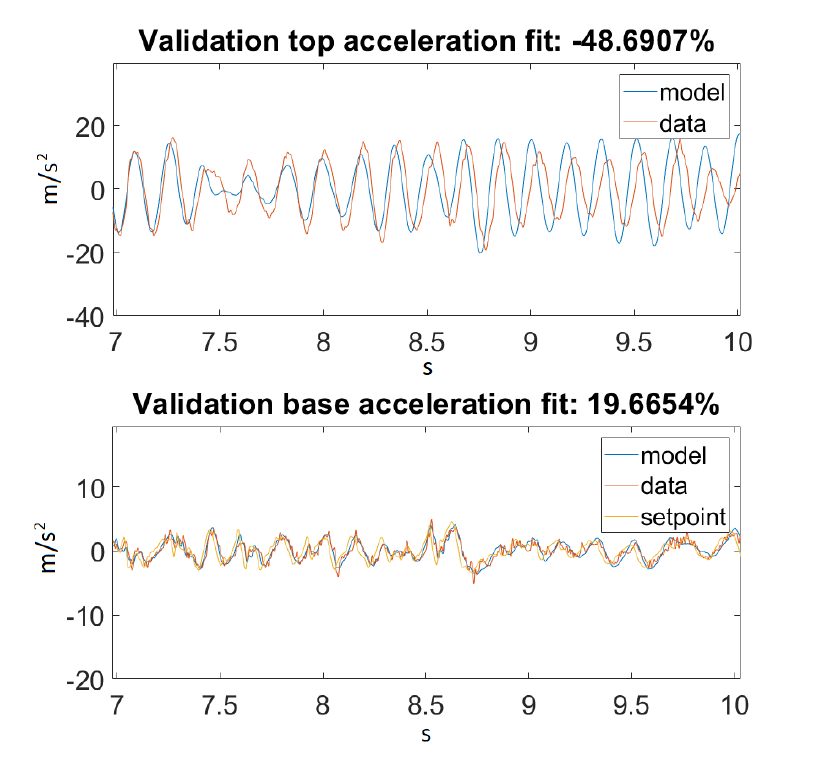
Figure 17. Best fit for Ground Motion 2, zoomed